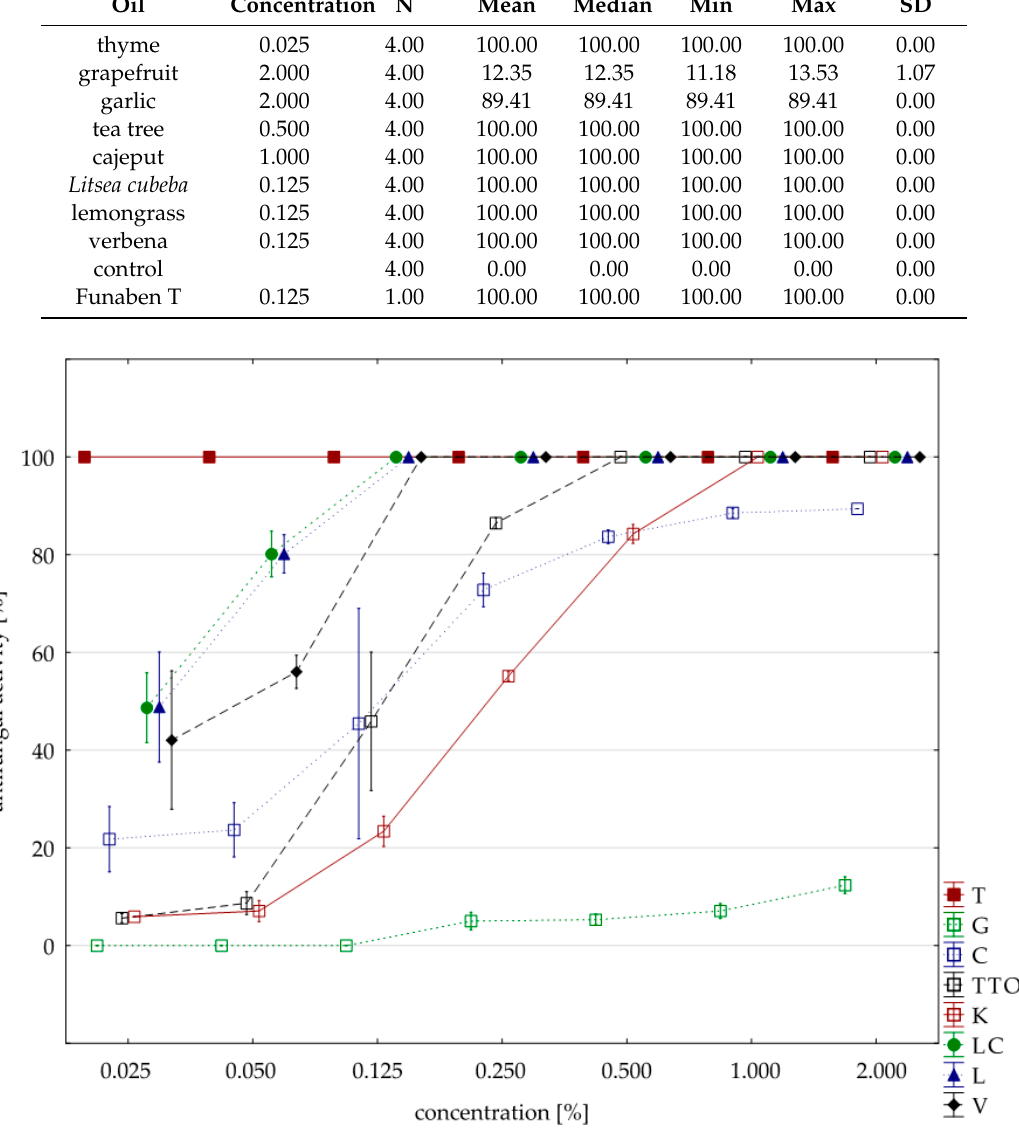
Figure 4. Plot of antifungal activity vs concentration for F . avenaceum.